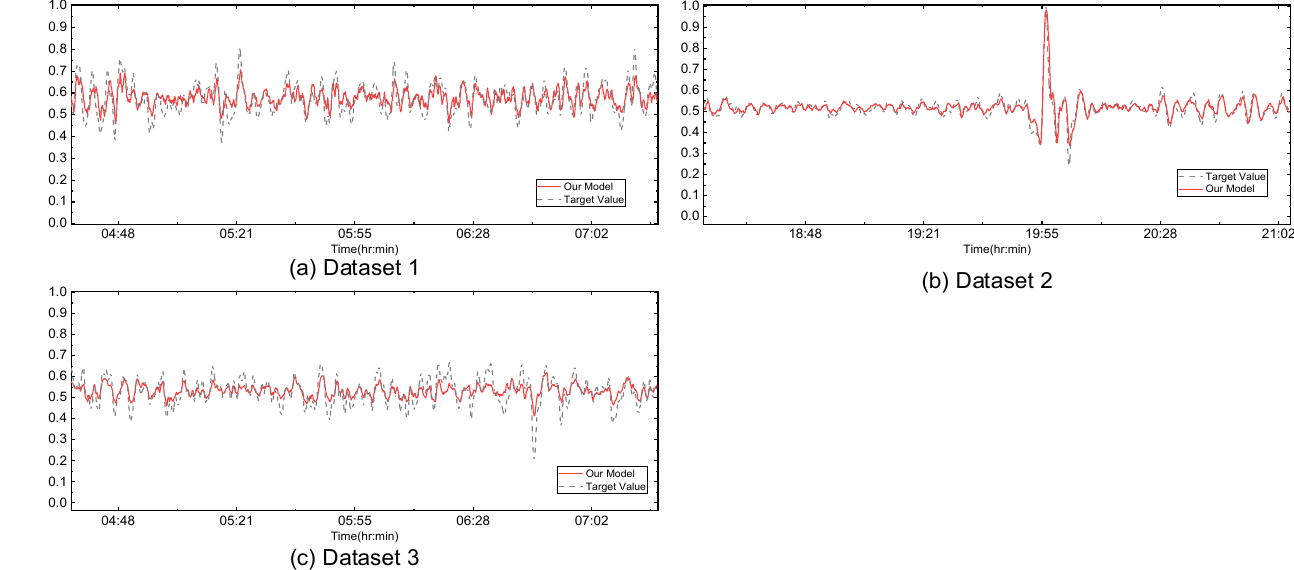
Figure 9. The prediction results diagram of differential value.